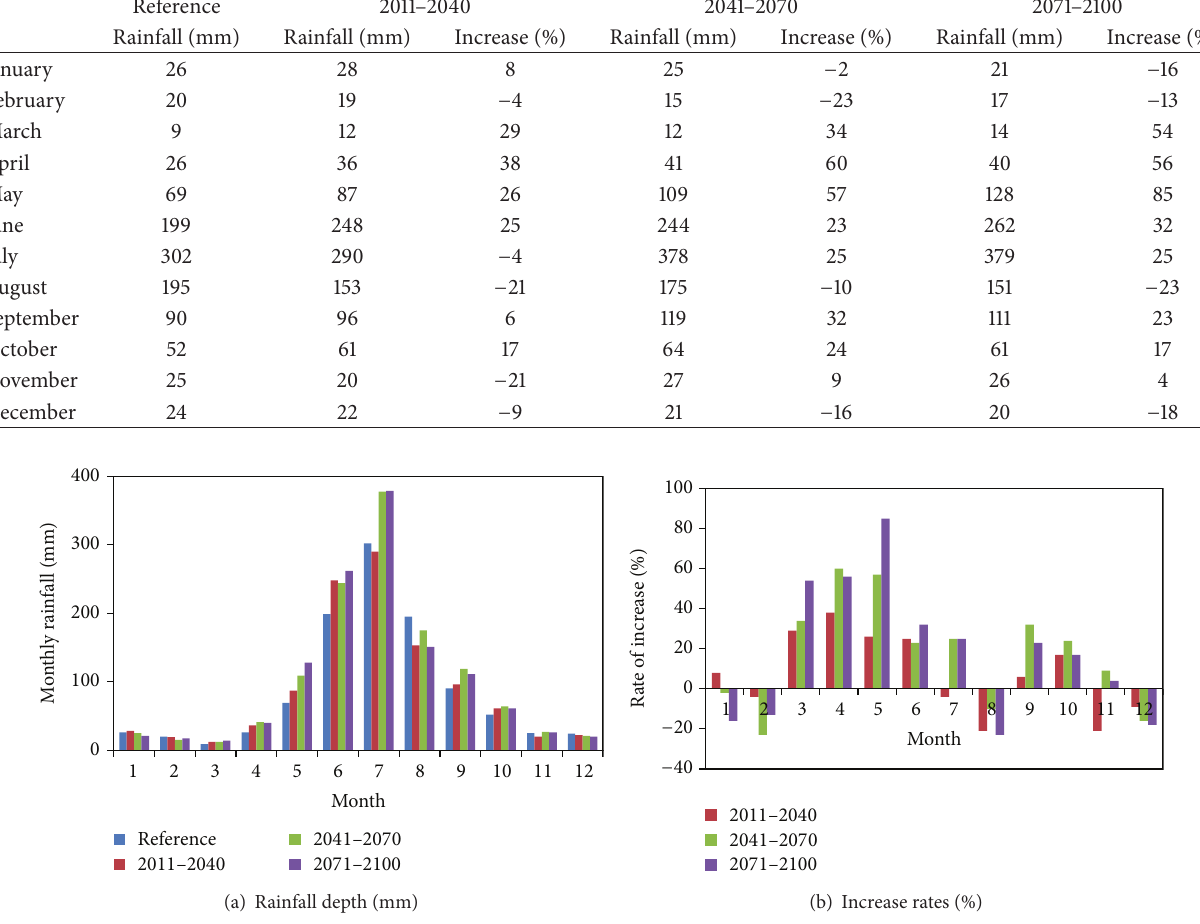
Figure 11: Change of monthly rainfall in each target